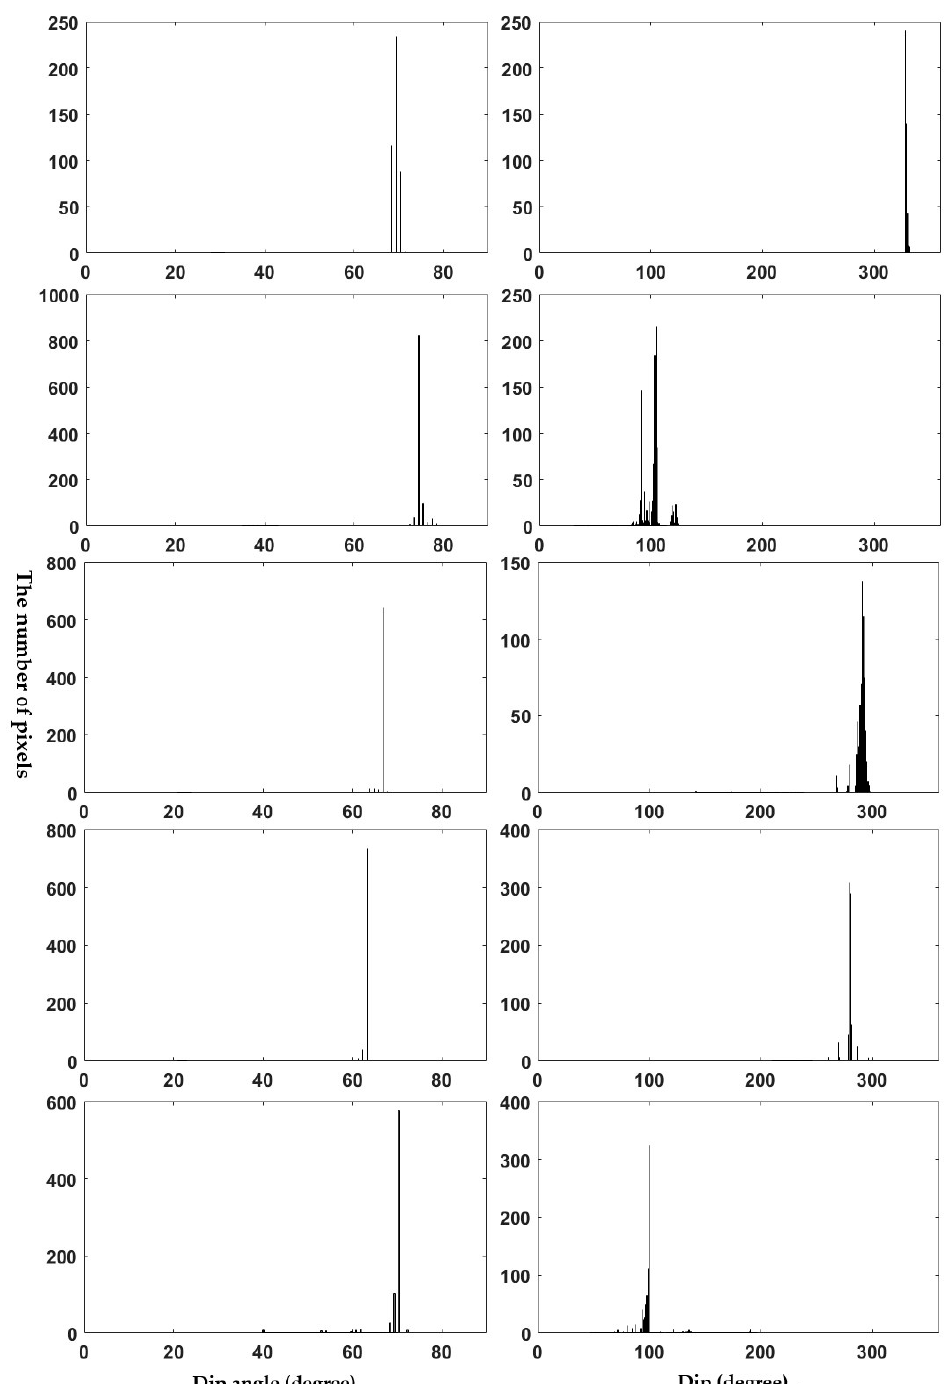
Figure 20. The histogram for attitude distribution of individual superpixel.